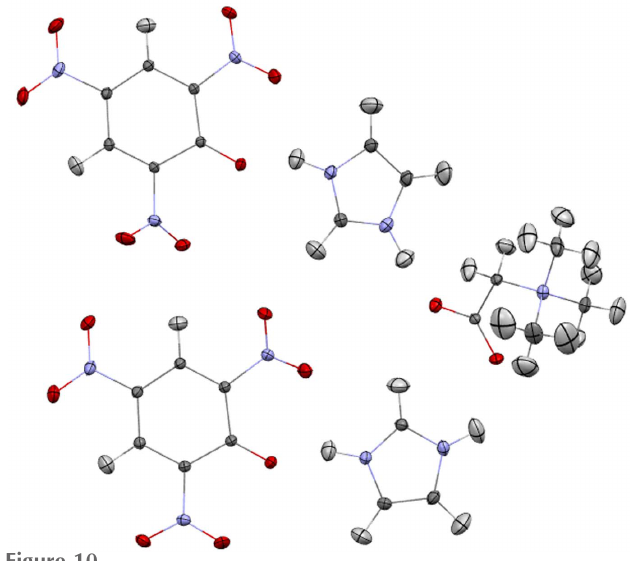
Figure 10 System used for testing fragmentation without breaking covalent bonds